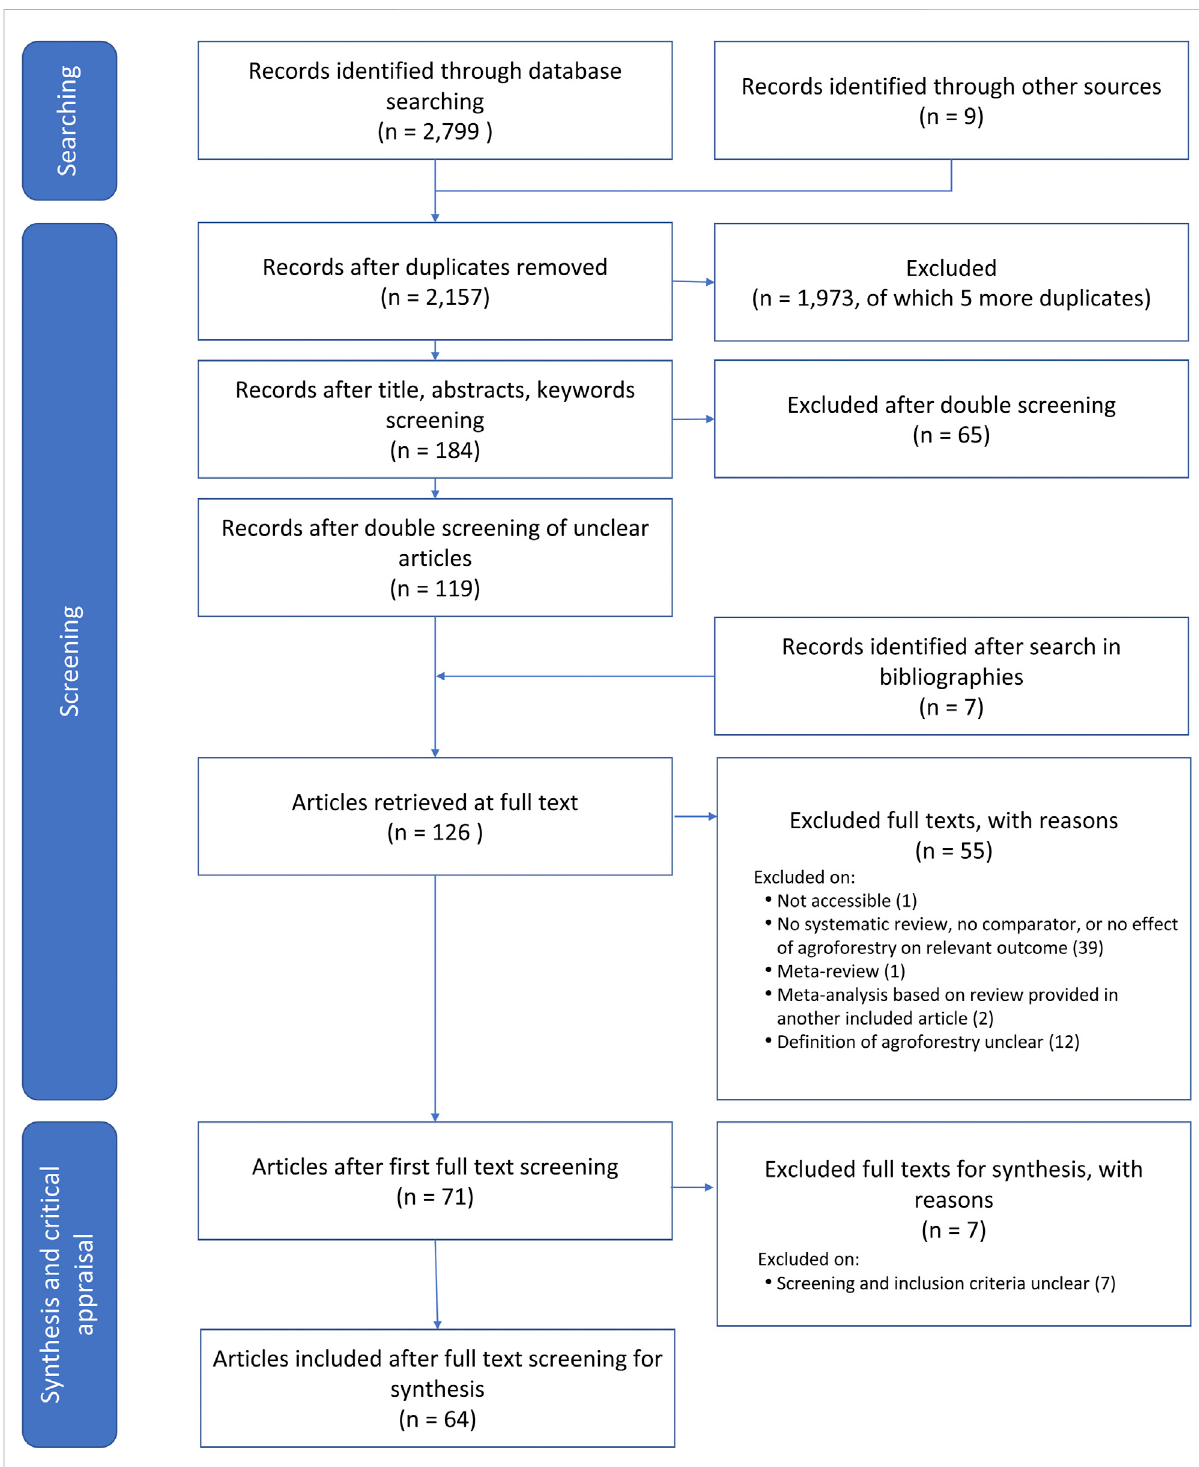
FIGURE 1 Flow diagram of study selection (template ROSES Flow Diagram for Systematic Reviews. Version 1.0). From 2,799 articles identi fi ed in an initial database search, 64 studies were selected by screening based on inclusion and exclusion